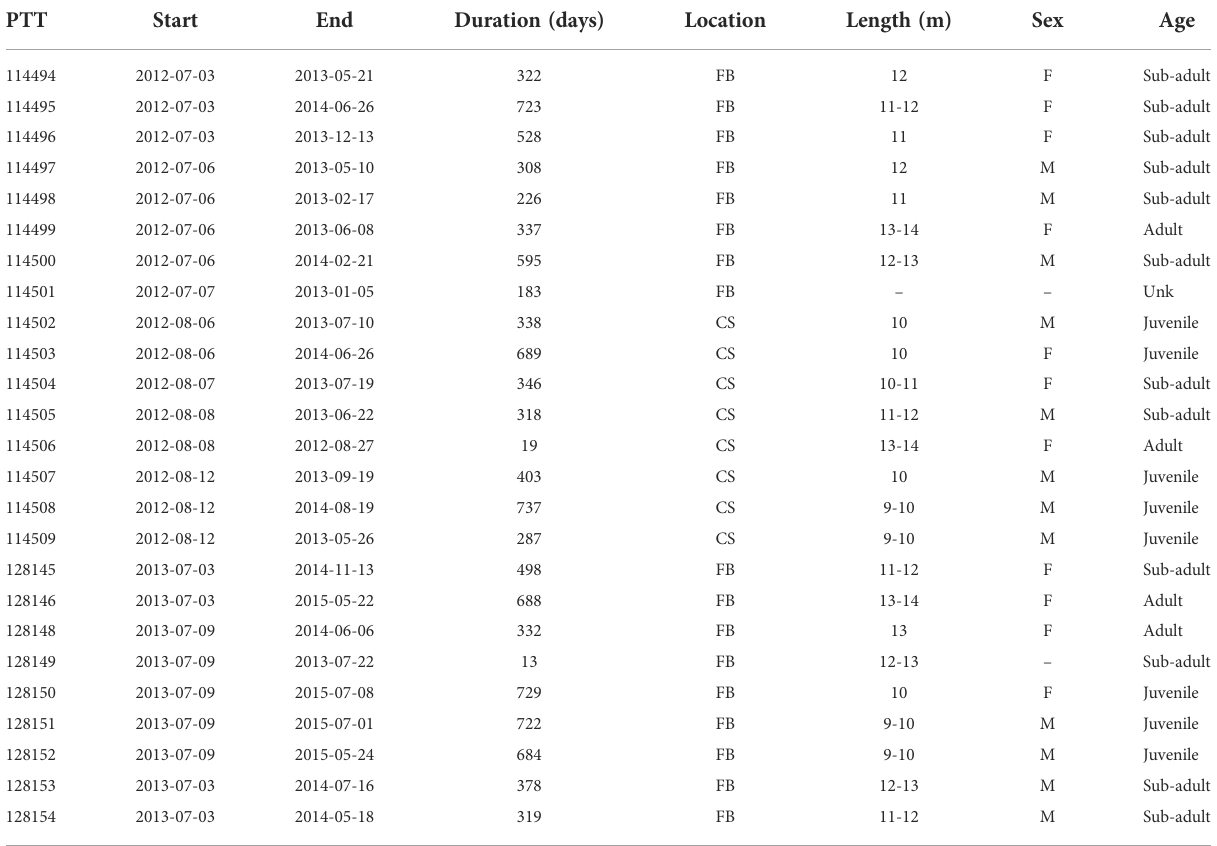
TABLE 1 Summary information for all bowhead whales tagged in Cumberland (CS) and Foxe Basin (FB) with Wildlife Computers SPLASH Tags (MK10) between 2012 and 2013.